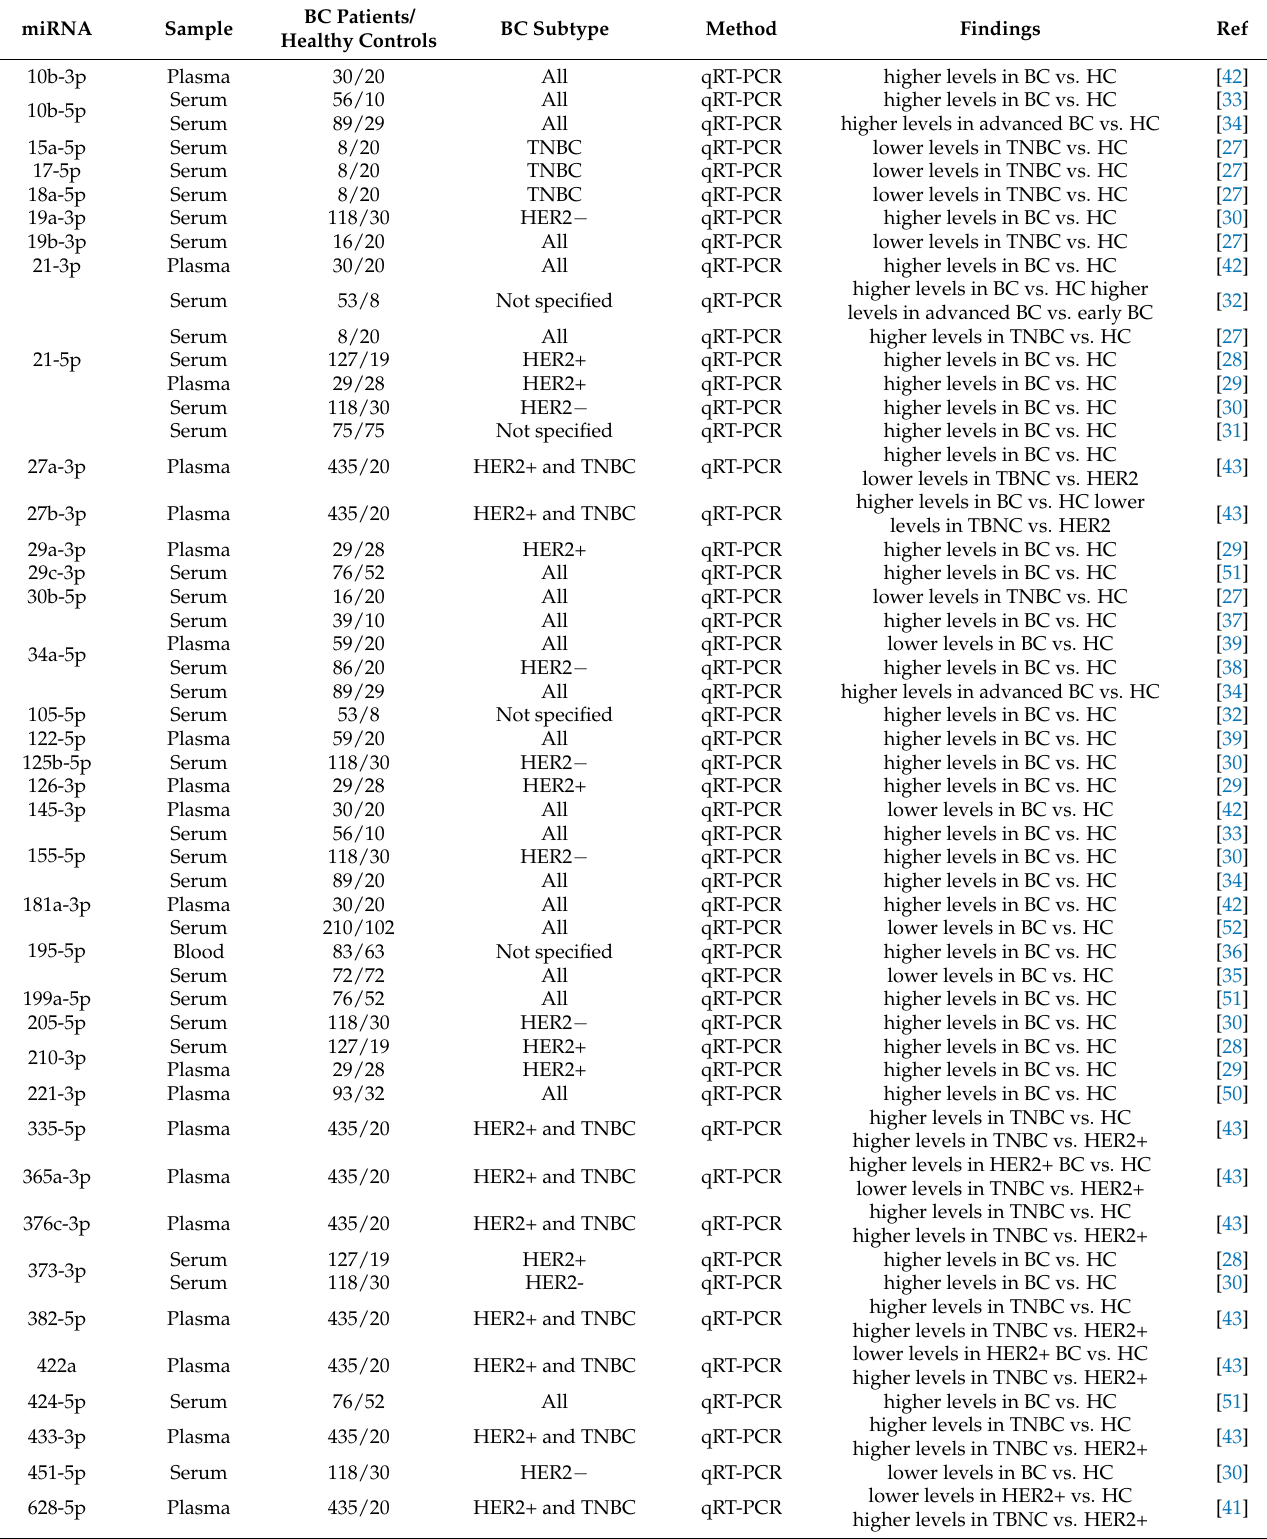
Table 1. Circulating miRNAs with a potential diagnostic role in differentiating between BC patients and healthy controls, BC molecular subtypes, and disease